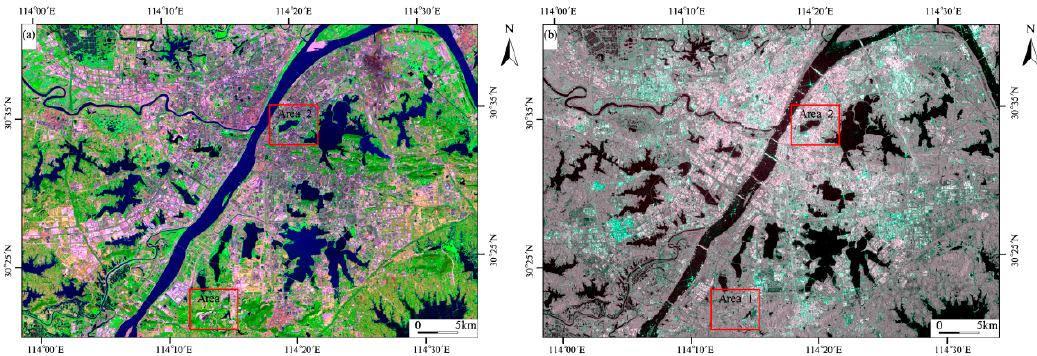
Figure 2. ( a ) False-color composite (red, band 12; green, band 8a; blue, band 2) Sentinel-2B MSI image acquired on 12 October 2018; ( b ) false-color composite (red, VH; green, VV; blue, VH+ VV) Sentinel-1A SAR image acquired on 16 October 2018.